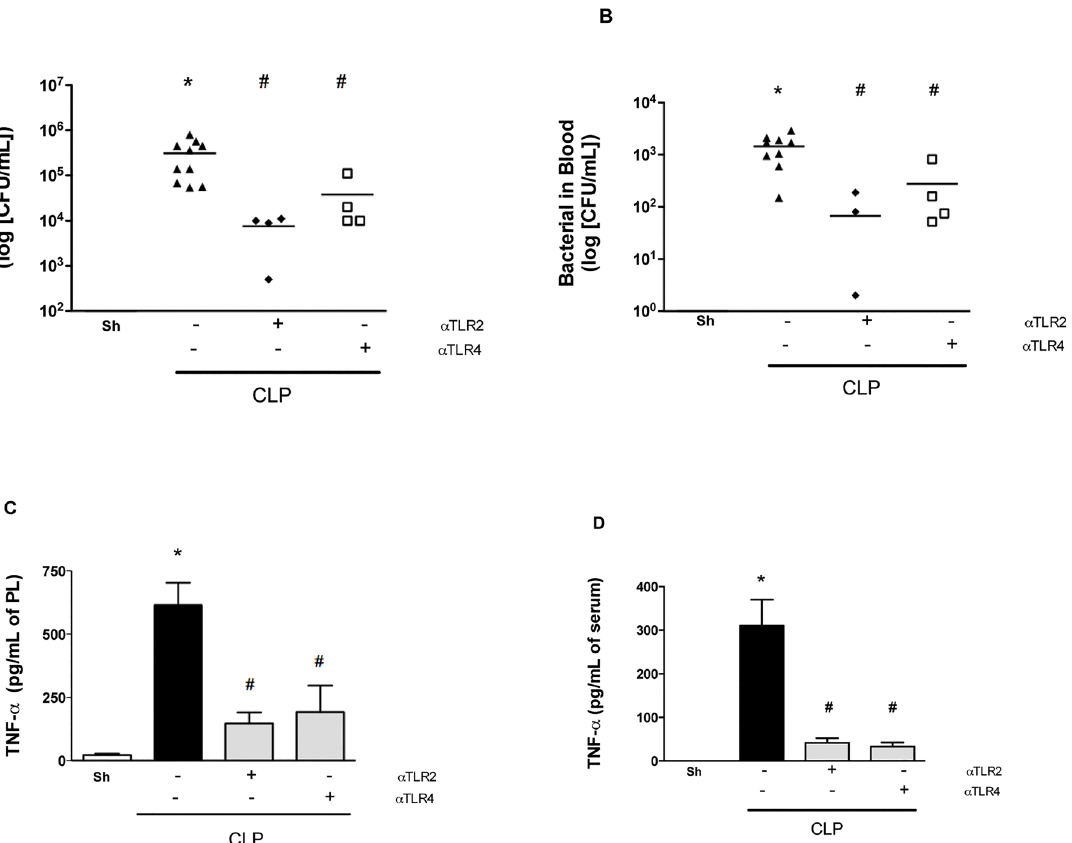
Fig 5. Therapeutic treatment with anti-TLR2 and anti-TLR4 improve sepsis. Mice were treated with individual anti-TLR2 or anti-TLR4 antibodies 3 hours after the CLP procedure. Treatment with both antibodies in combination decreased the number of bacteria in the peritoneum (A) and serum (B) as well as the levels of TNF- α in the peritoneum (C) and serum (D) 6 hours after sepsis compared to the negative control isotype IgG antibody treatment (CLP). * p < 0.05 between CLP and Sham groups. # p < 0.05 between the antibody treatment and negative control isotype IgG treated-group. Horizontal bars in Fig 5A/5B represent median value. Antibody dose (1 mg/animal). Used 6 animals/group, except isotype IgG antibody treated group (n = 10). Missing points in Figs reflect number of bacteria below detection